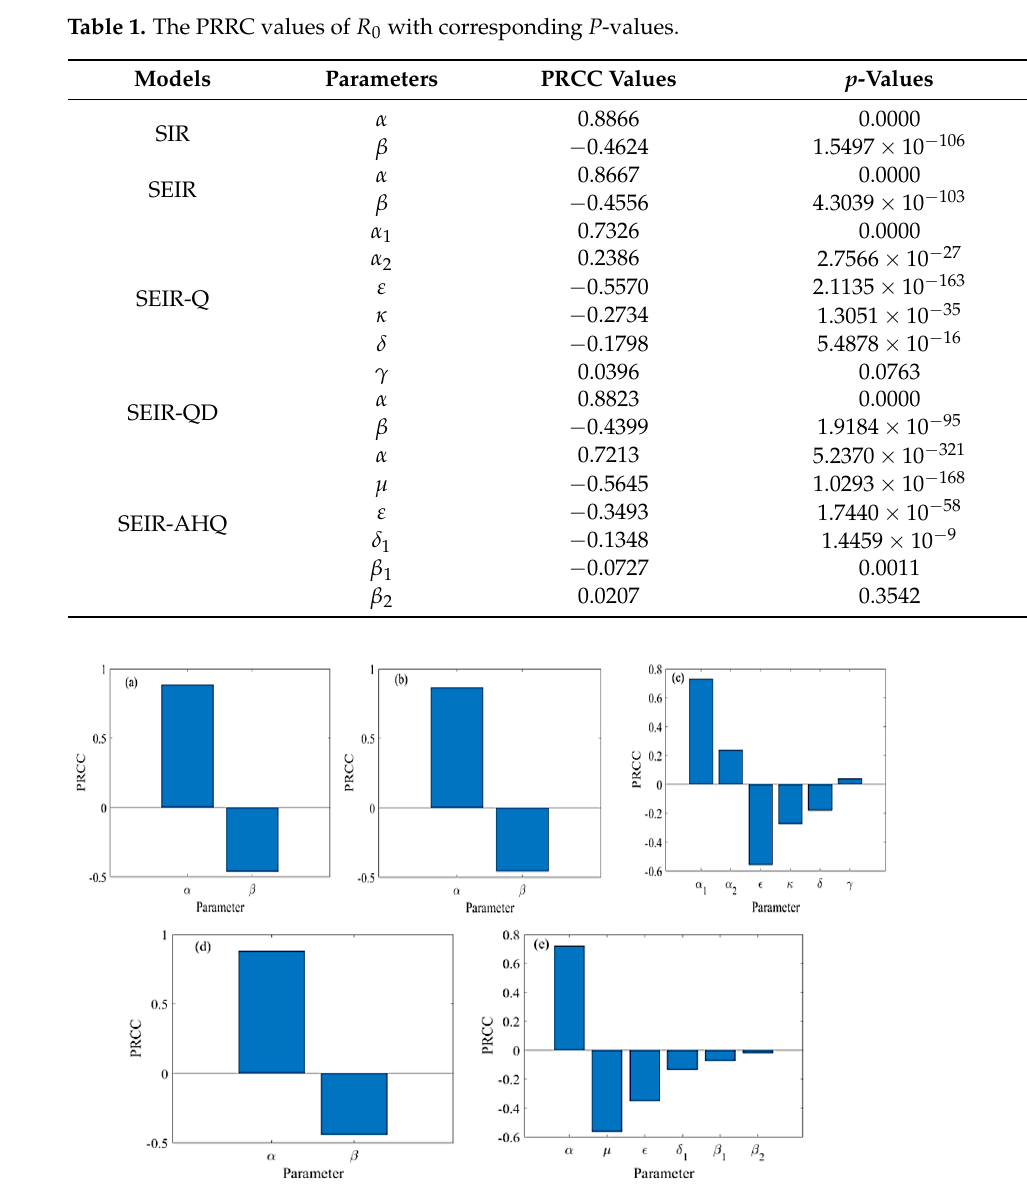
Figure 5. The PRCC results of parameters involved in R 0 . ( a ) SIR; ( b ) SEIR; ( c ) SELR-Q; ( d ) SEIR-QD; ( e ) SEIR-AHQ.